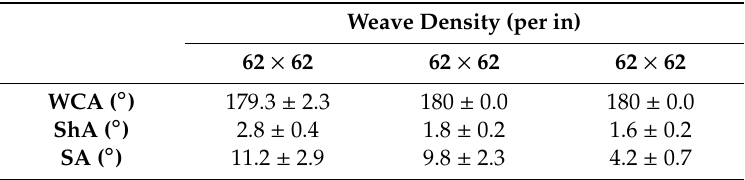
Table 4. Water contact, shedding, and sliding angles of the PP fabric that underwent plasma etching for 15 min and thermal aging for 24 h (E15H120 24